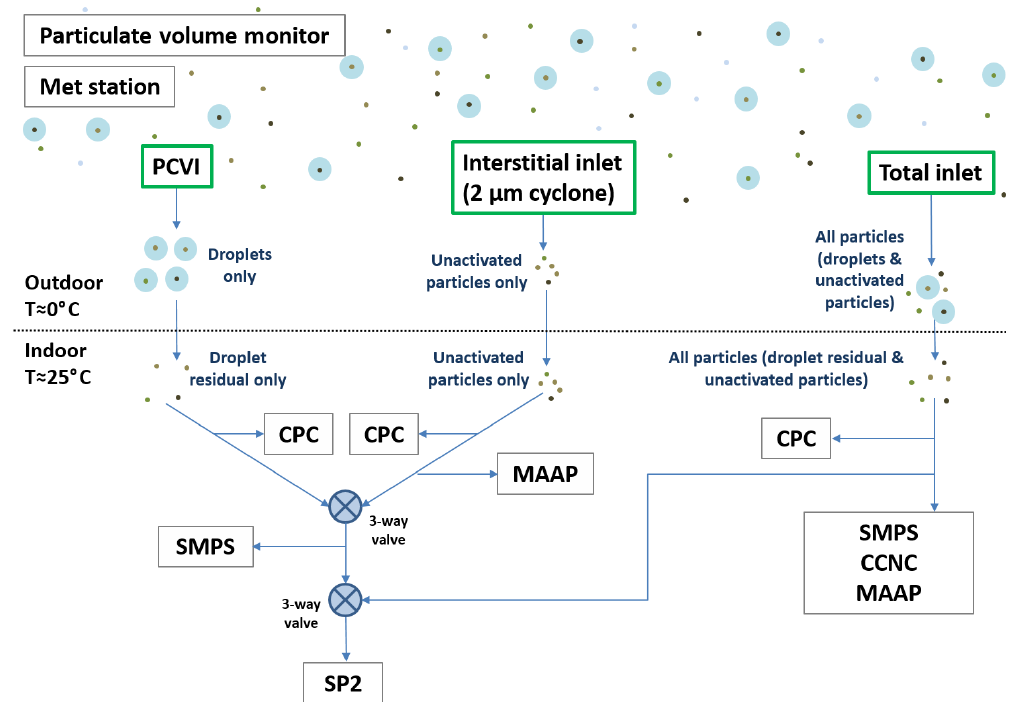
Figure 1. Instrumental set-up. Green rectangles indicate inlets and black rectangles indicate instruments. Acronyms: PCVI, pumped coun- terflow virtual impactor; CPC, condensation particle counter; MAAP, multi-angle absorption photometer; SMPS, scanning mobility particle sizer; SP2, single-particle soot photometer; CCNC, cloud condensation nuclei counter. Drying of the sample air occurs through the tempera- ture increase from outdoor to